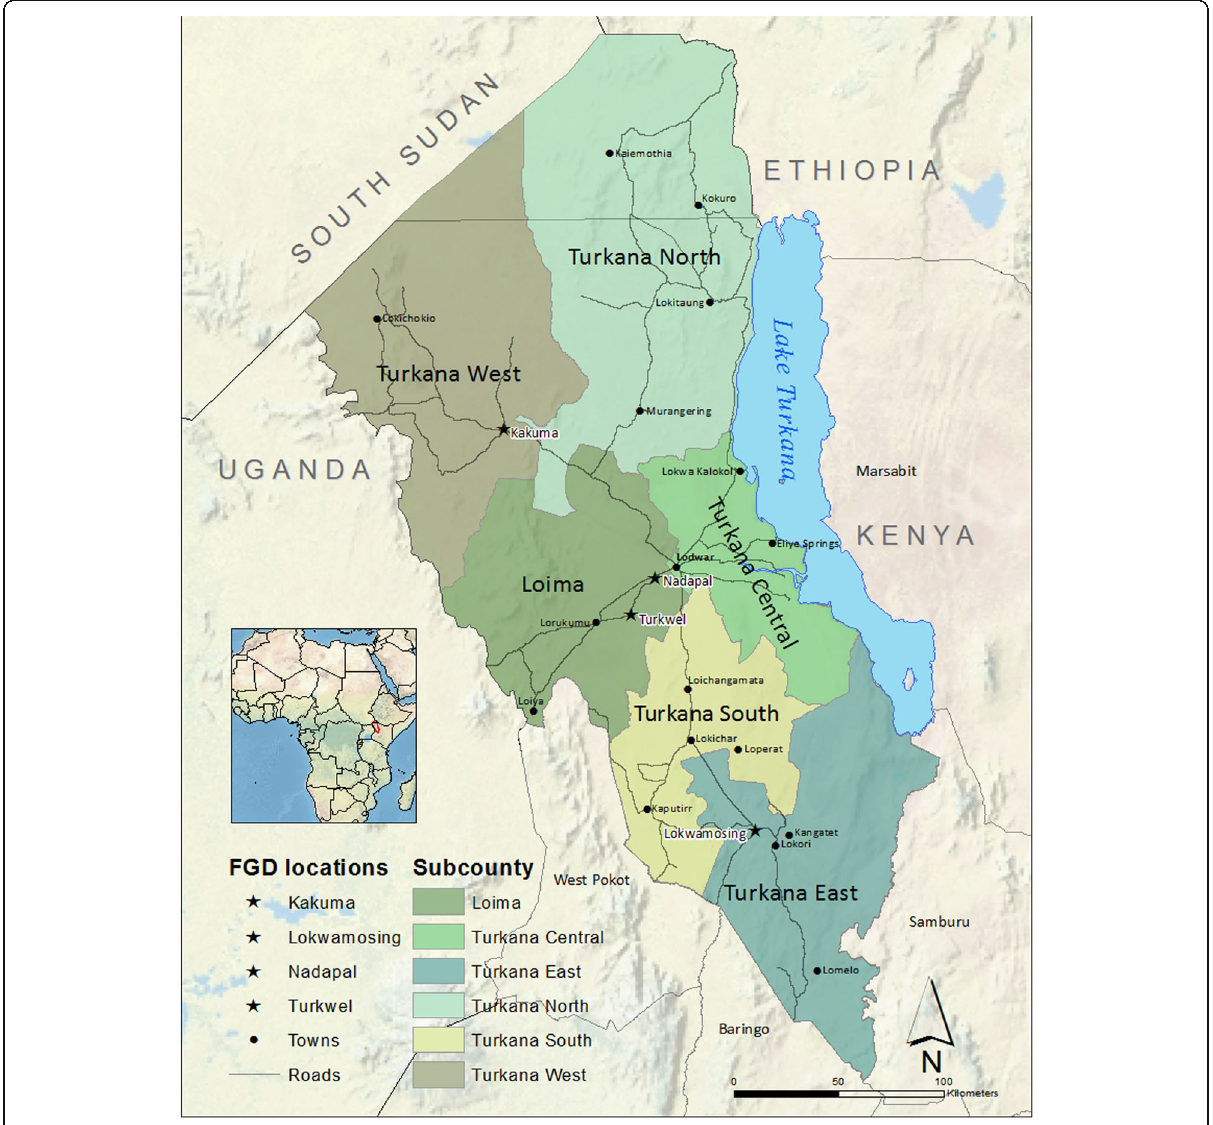
Fig. 1 Turkana County, Kenya, with pastoralist FGD locations. Created with ArcMap